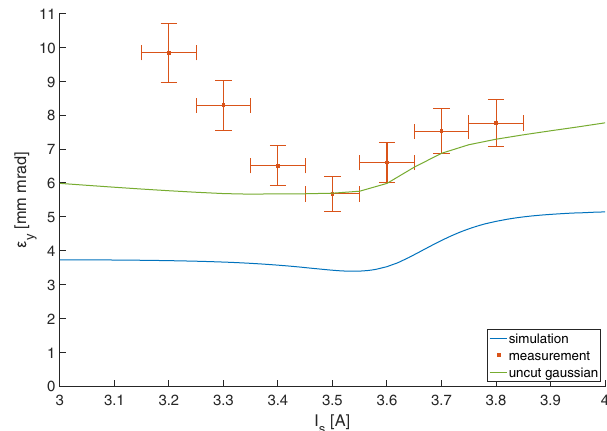
FIG. 16. A solenoid scan for a bunch charge of 160 pC at an accelerating gradient of about 7 . 2 MV = m: Varying the solenoid current clearly affects the transverse emittance. How- ever, especially the results for lower currents, i.e., less focusing deviates significantly from simulation. This is most likely caused by the larger contribution of outside particles and the hence enhanced beam radius to the total emittance. Using an uncut Gaussian for the initial charge distribution yields better agreeing simulation results, however, still lacks agreement for the lower current